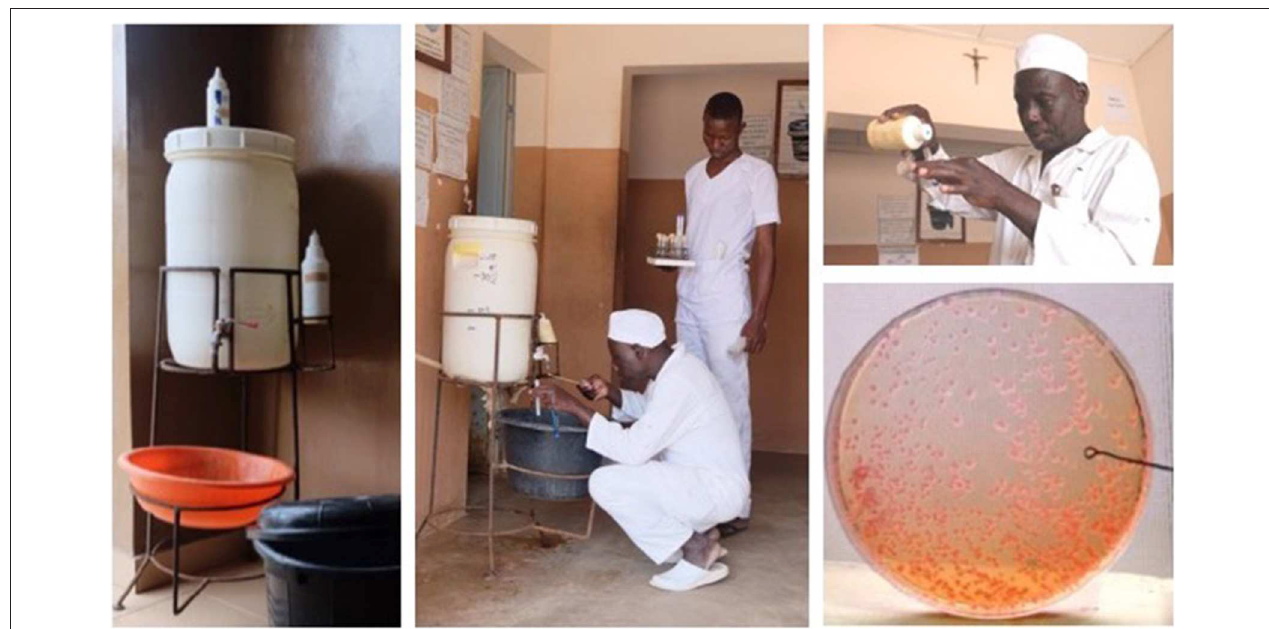
FIGURE 1 | Benin, West-Africa: mobile hand washing facility. The water in the reservoir is a 0.05% chlorine solution which was added when the reservoir was nearly empty. Two containers with liquid soap (top and right side of the reservoir) were topped-up when needed. Simple swabbing of the tap and semi-quantitative culture of the soap (calibrated loop) was performed on standard culture media (MacConkey agar). Tap and soap were heavily contaminated with multidrug resistant Klebsiella pneumoniae . Simple control measures (daily cleaning and drying of the reservoir (system of alternating two reservoirs), replacing the containers instead of topping-up) stopped the contamination. Follow-up cultures were done during the implementation phase of the control measures. Written informed consent was obtained from the individual for the publication of this